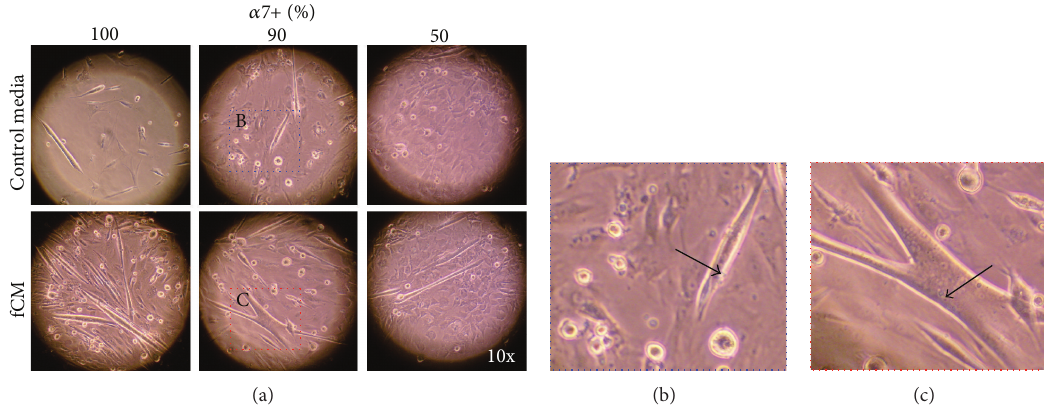
Figure 4: Morphology of muscle tissue sheets. (a) Live culture images from tissue sheets with varying 𝛼 7+ concentration (100, 50, 90%) in either control media (top panel) or fCM (middle panel). Enlarged representative sections from 90% 𝛼 7+ tissue sheets cultured in (b) control media and (c) fCM demonstrate that the myofibers in fCM are longer and thicker.